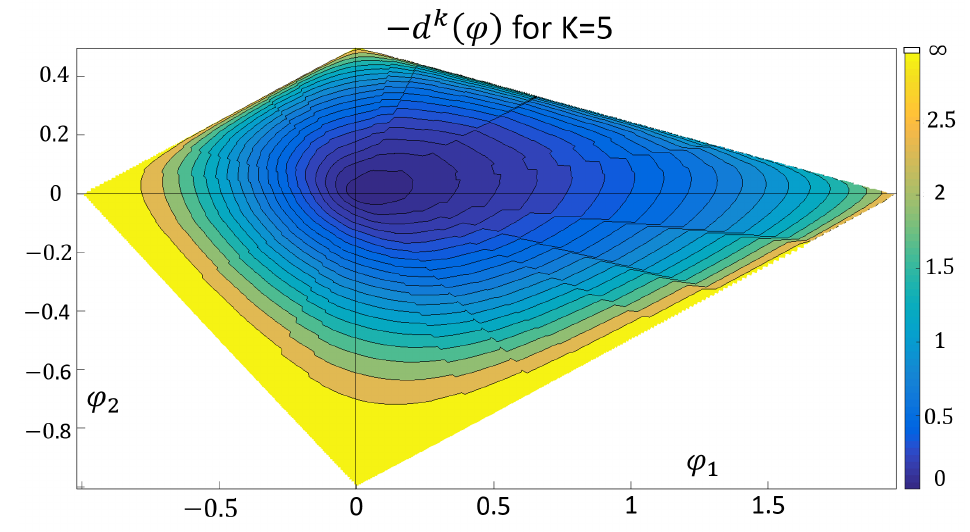
Figure 3. Discontinuous contour levels for